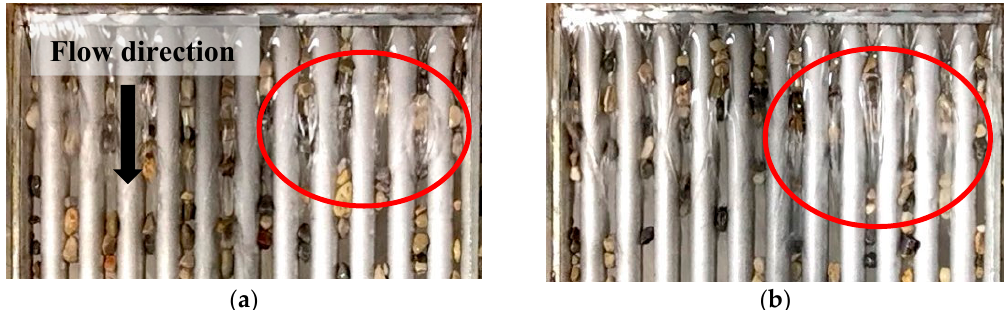
Figure 9. Flow over the occluded circular bars bottom rack and formation of wakes for rack slopes: ( a ) 20%; ( b ) 30%.